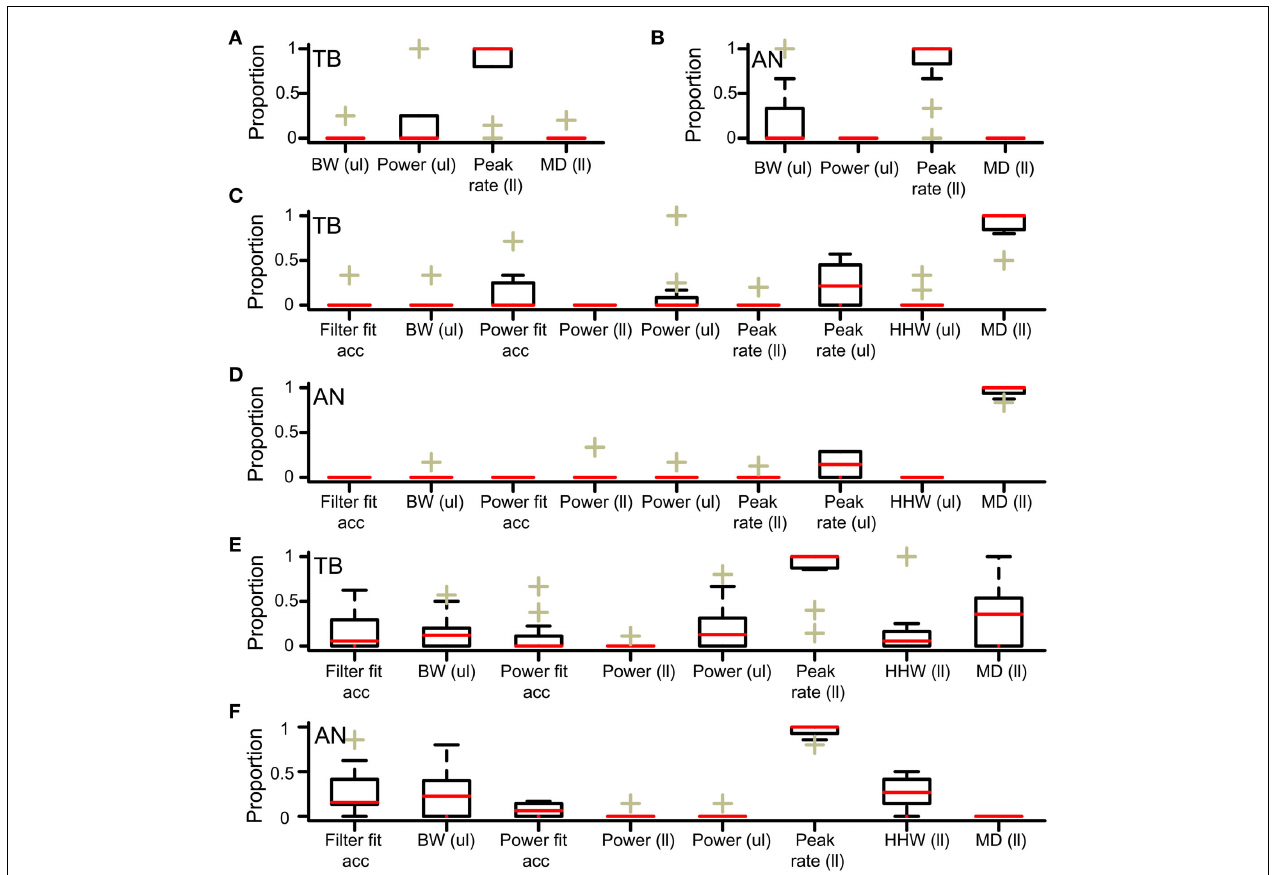
FIGURE 6 | Acceptance criteria responsible for failure of simulations (A,B). Acceptance criteria responsible for failure of simulations with one unilateral input less than the minimally required N . Only criteria involved in at least one simulation failure are shown. The proportion of failed simulations due to each criterion is shown for all datasets. Each box is bordered by the upper and lower quartile, and the median is indicated by a red line. The whiskers indicate a range of 1.5 times the interquartile